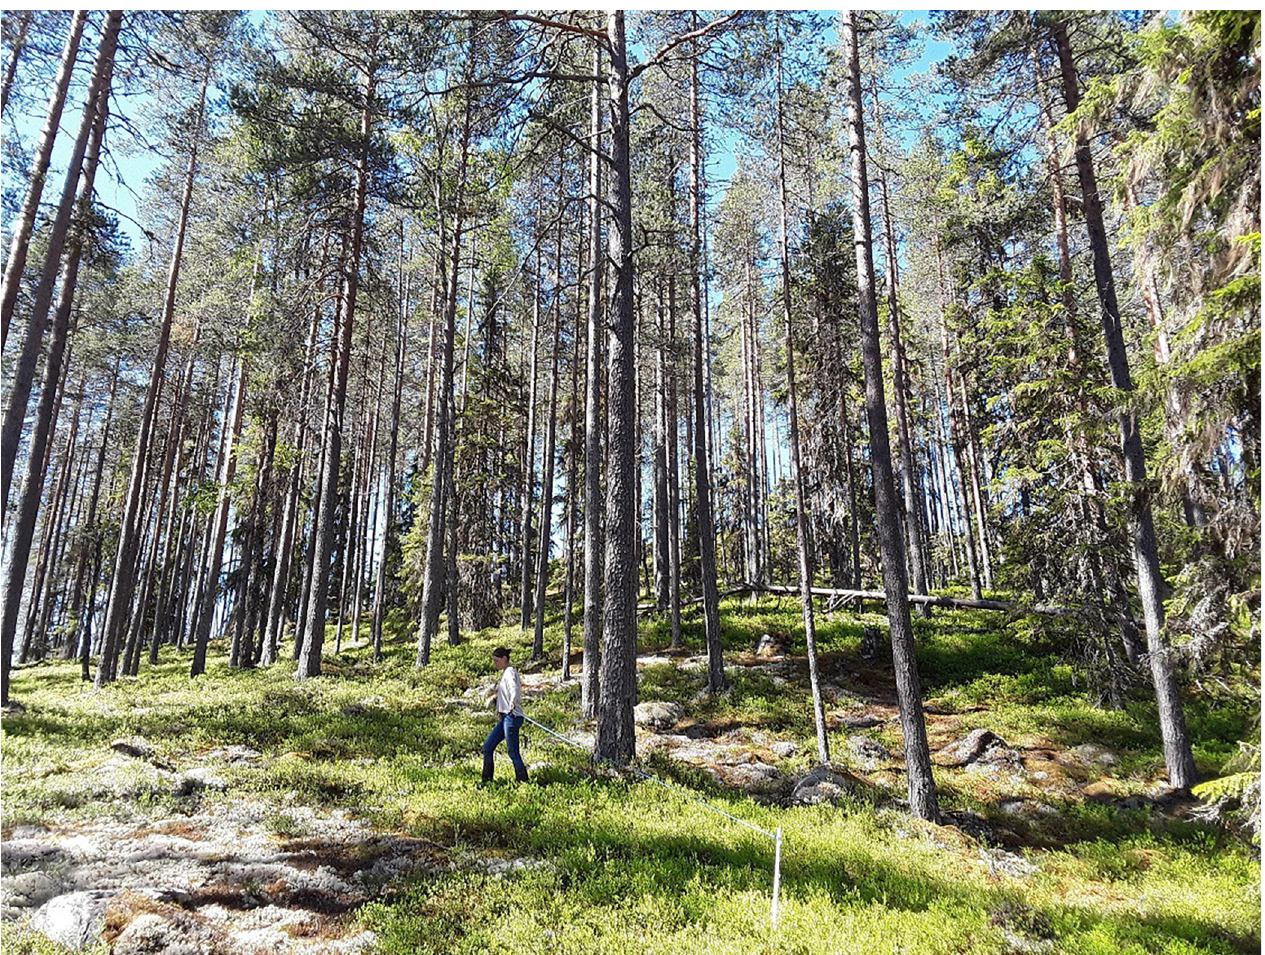
Fig 2. An observer conducts a moose pellet group survey in Norway. This plot represents a typical Norwegian production forest with minimal structural diversity. Photo credit Annie